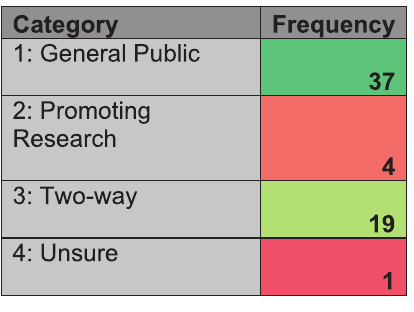
Figure 3. Major categories for ‘definitions of public engagement’ and frequencies; listed in alphabetical order and colour coded according to frequency.